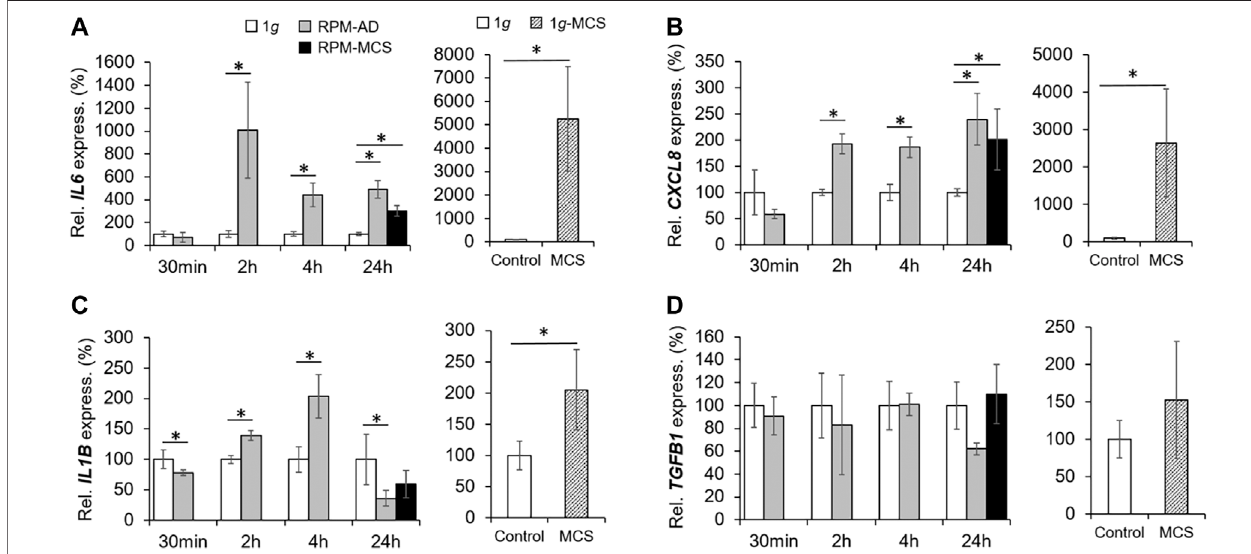
FIGURE5| Proin fl ammatorycytokines: Gene expression of (A) IL6 and (B) CXCL8 mRNA, (C) IL1B ,and (D) TGFB1 ofPC-3 cellsexposed totheRPM for30 min, 2, 4 and 24 h and 1 g -MCS after 24 h. n = 5; * p < 0.05 vs. 1 g .